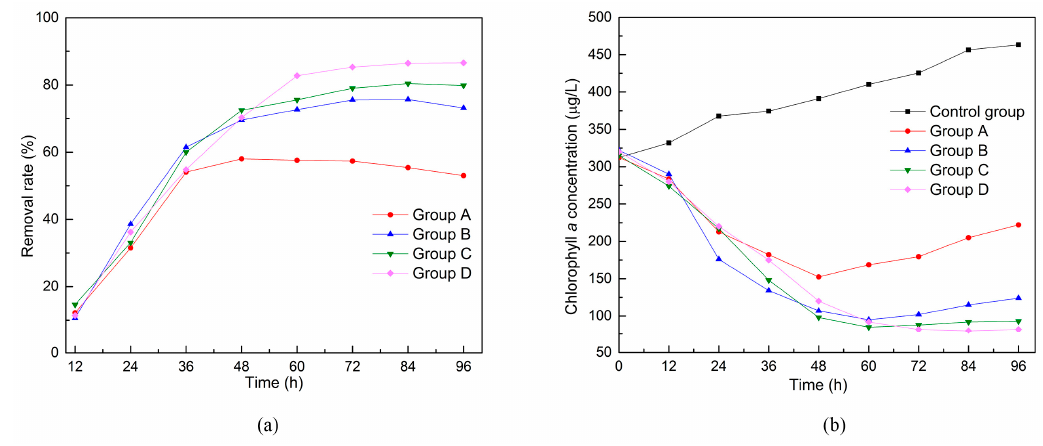
Figure 7. ( a ) Algae removal rates and ( b ) concentrations of chlorophyll a under different modes of ultrasonic radiation treatment for algae removal.